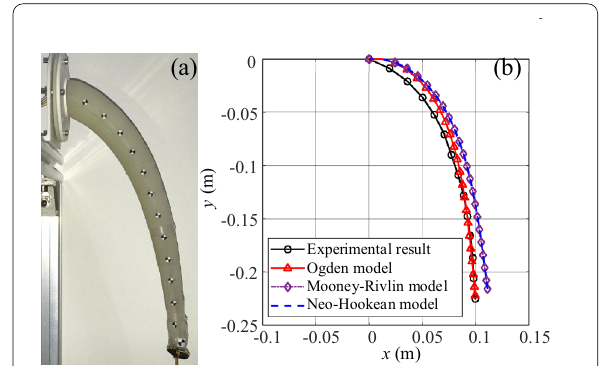
Figure 10 Experimental results of the cantilever arm and comparison with the